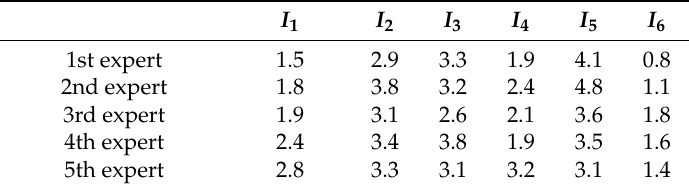
Table A16. Scores of environmental management maturity in the criteria layer